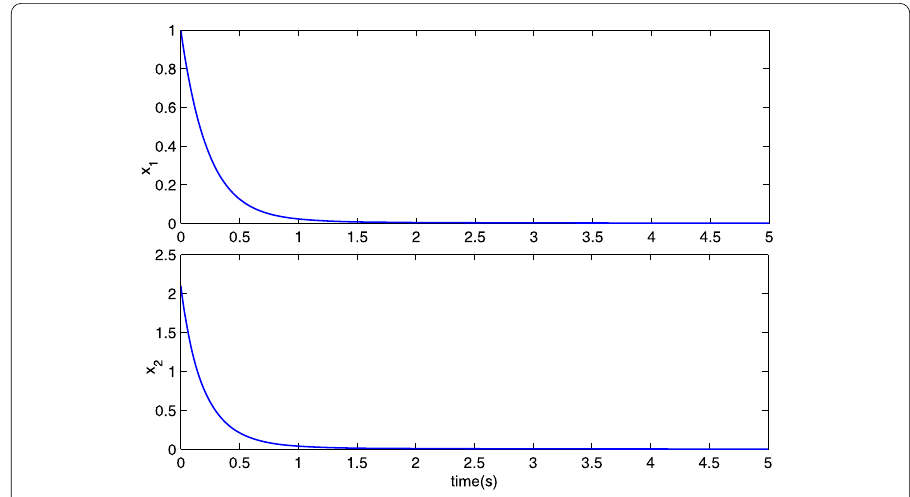
Figure 3 Asymptotic stabilization of system (4.1) with feedback gain K =